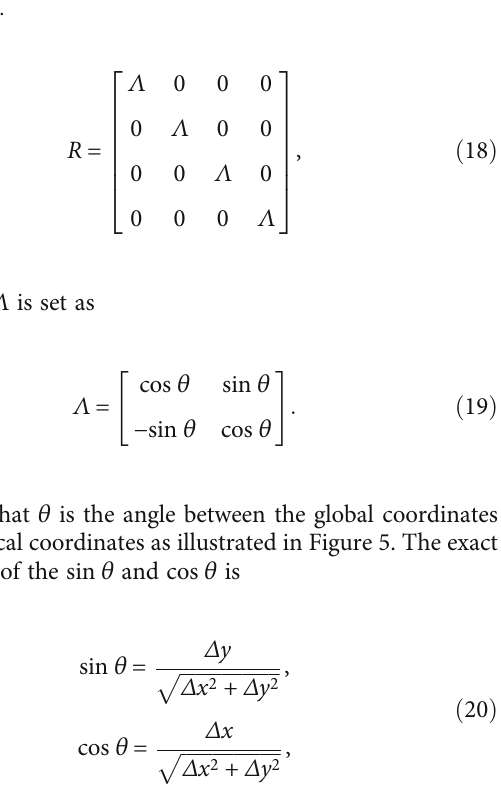
Figure 5: 2D cohesive zone element and displacements in the local